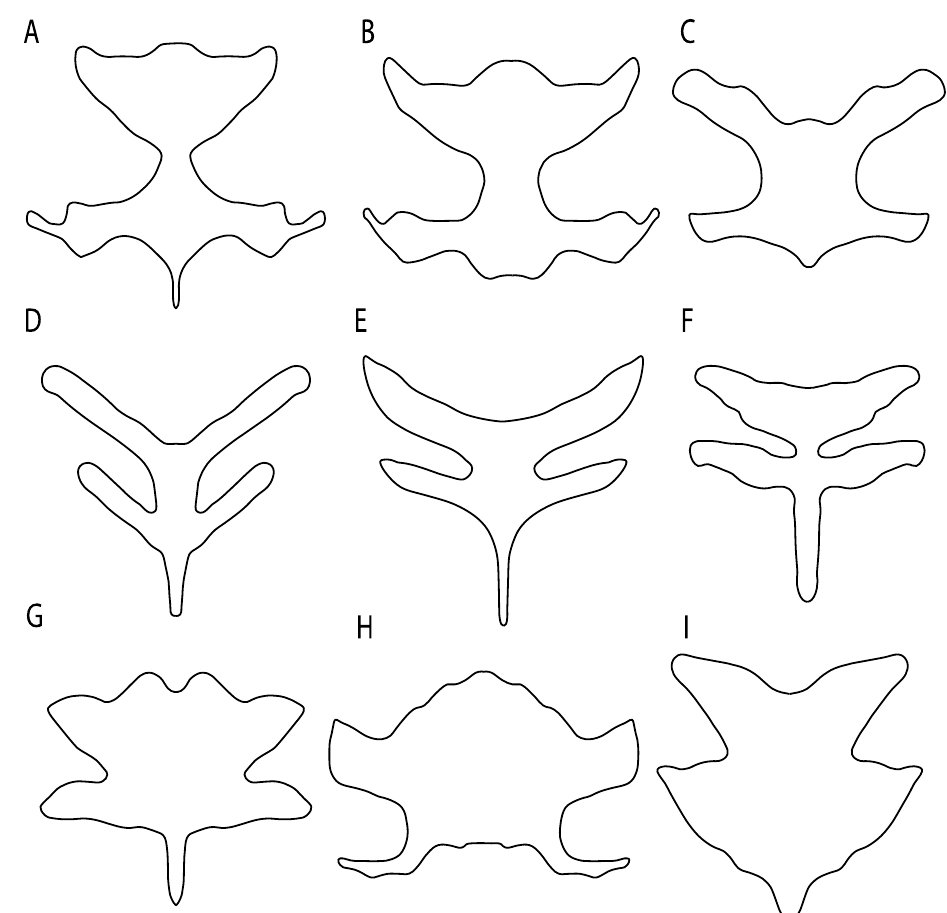
Figure 33. Interpretative drawings of suprascapula in dorsal view. State (0): ( A ) Platyrhina sinensis (MNHN 1307); ( B ) Platyrhinoidis triseriata (MNHN 3211). State (1): ( C ) Aptychotrema vincentiana (CSIRO 101, https://sharksrays.org/ (accessed on 23 March 2020)); ( D ) Glaucostegus sp. ( NHMUK 1967-21-13); ( E ) Pseudobatos percellens (UERJ 1240). State (2): ( F ) Rhynchobatus springeri (https://sharksrays.org/ (accessed on 23 March 2020)); ( G ) Rhina ancylostoma (LACM 38117-38, https://sharksrays.org/ (accessed on 23 March 2020)); ( H ) Pristis zijsron (ANSP 101398) redrawn and modified from da Silva and de Carvalho Text-Figure 19 in [22]. State (3): ( I ) Zapteryx exasperata (CNPE-IBUNAM 20528).